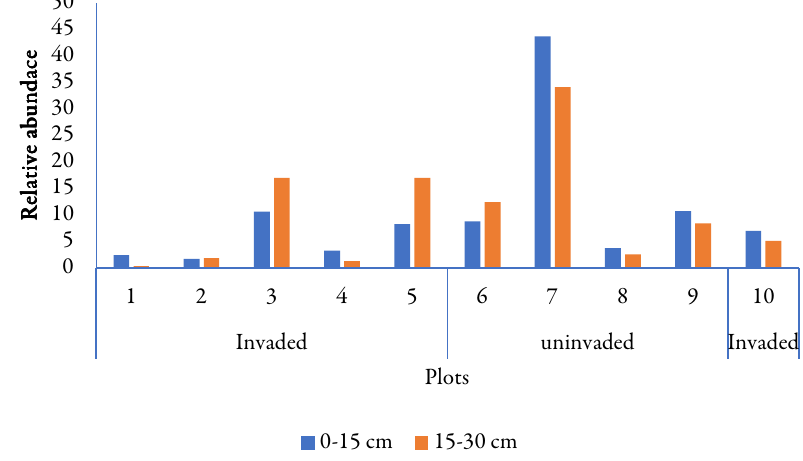
Figure 4. Relative abundance of species recruited from the soil seed